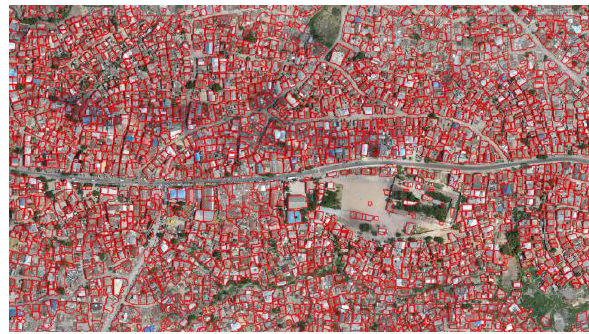
Figure 8 . 3 Dataset from Tanzania ( Source : OpenAerialMaps )